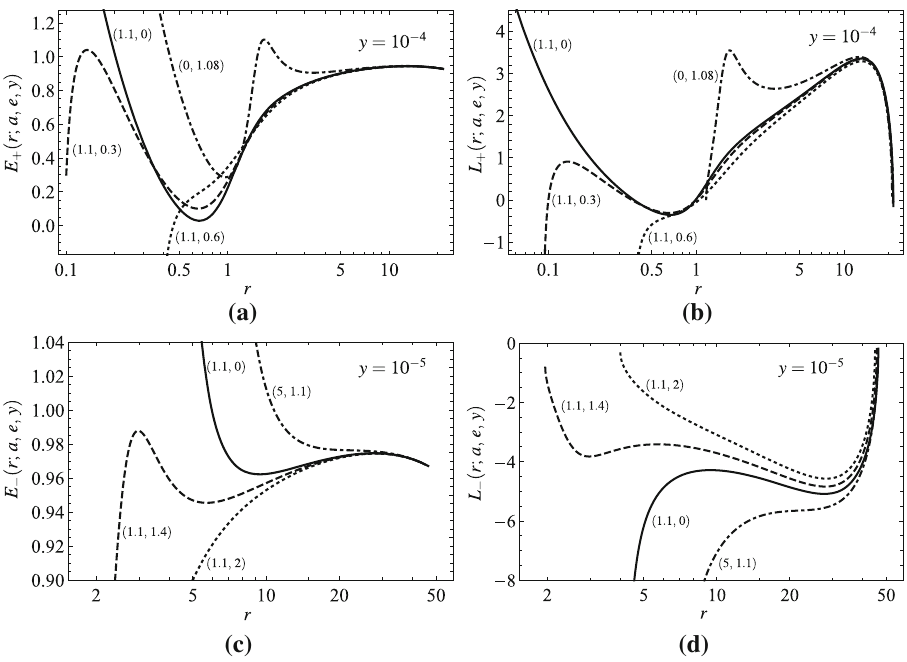
Fig. 3 Radial profiles of specific energy and specific angular momentum of test particles moving on equatorial circular orbits around KNdS naked singularities with spacetime parameters shown in each panel. Values of rotational and charge parameters ( a , e ) are assigned to each curve separately. a , b Correspond to the plus-family orbits, while the c , d correspond to the minus-family